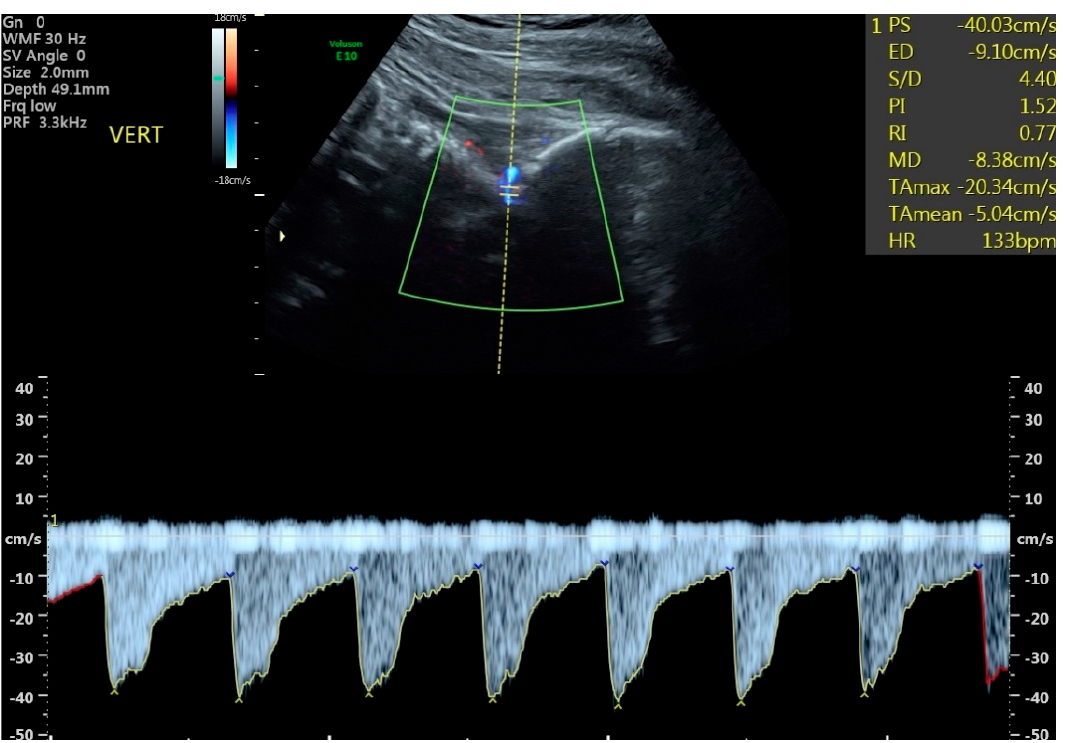
Figure 2 . Vertebral artery Doppler. Example of vertebral artery Doppler measurement in a fetus affected by fetal growth restriction.